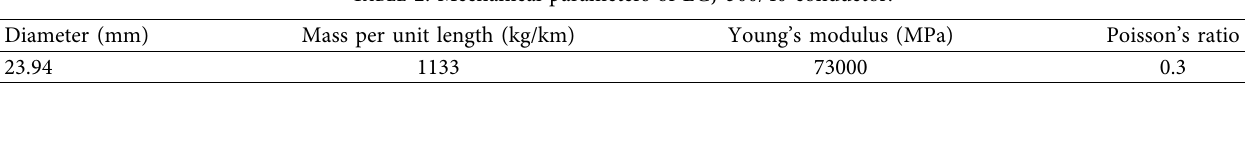
Table 3: Equivalent mechanical parameters of D-shaped ice-covered conductors.